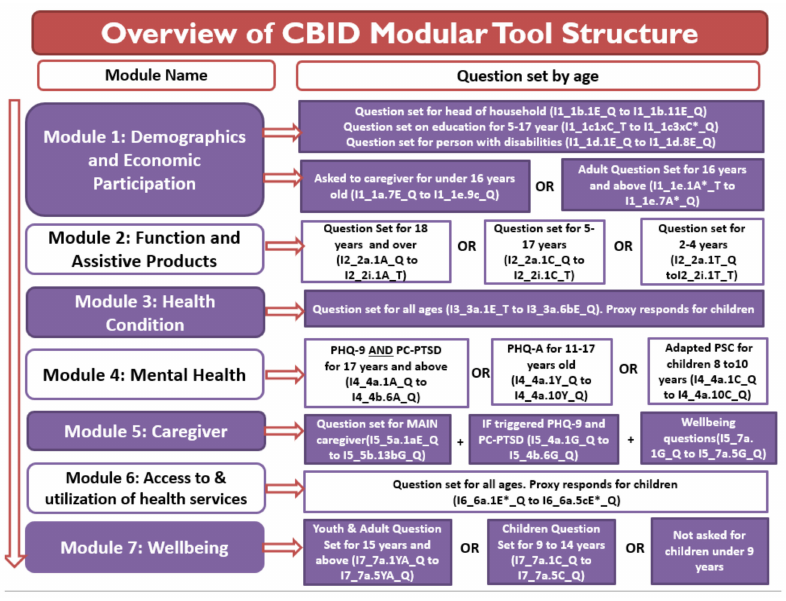
Figure 2. CBID modular tool